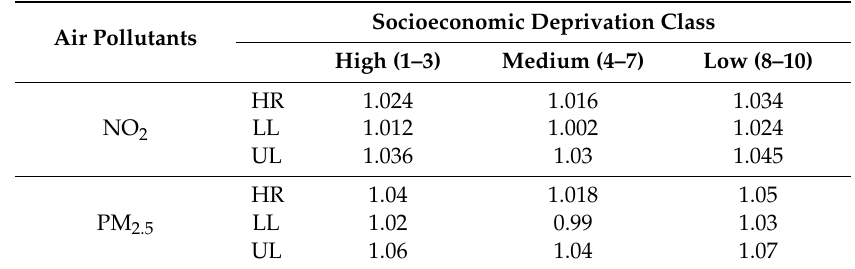
Table 4. Associations between long-term NO 2 and PM 2.5 exposure and mortality all-causes by socioeconomic class extracted from the Italian study